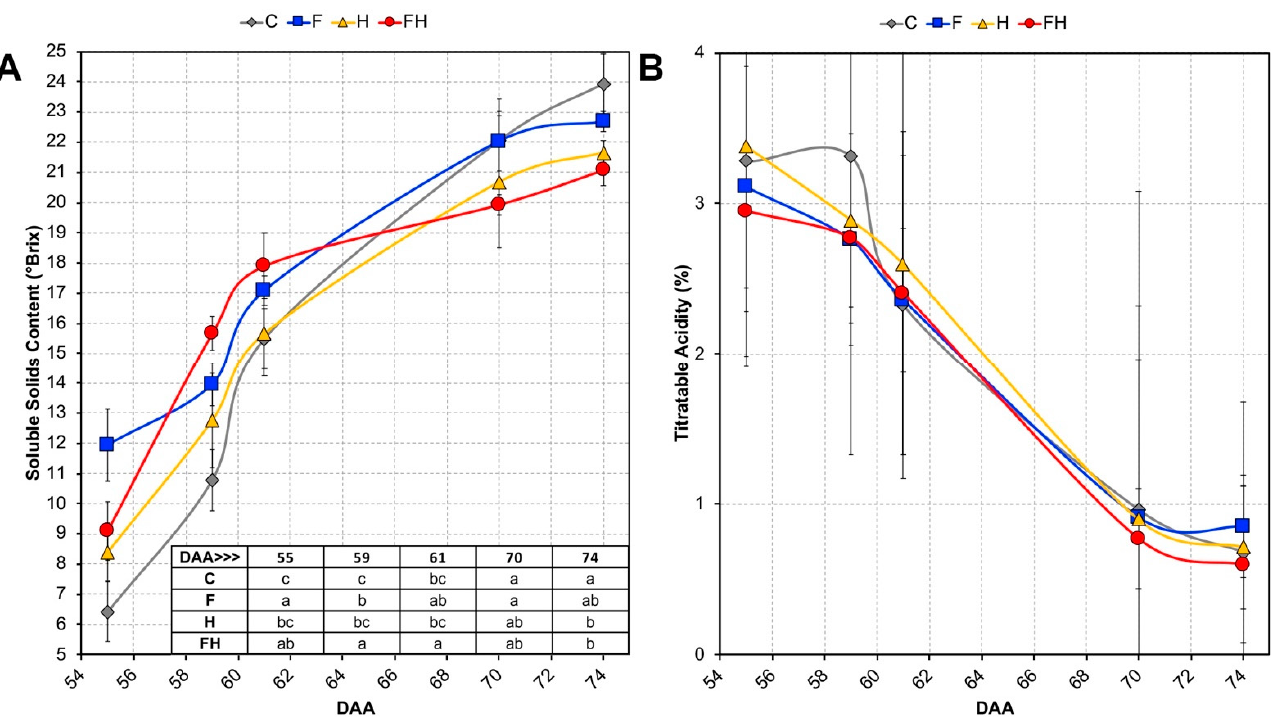
Figure 2. Soluble Solids Content (SSC; ( A ) and Titratable Acidity ( B ) were measured in 10 berries of each treatment, starting from the day when temperatures were increased (T1, 55 DAA) up to the end of the experiment, when berries were harvested (T5, 74 DAA). Bars represent standard error. Statistics were reported only for SSC with different letters marking statistically significant differences, while for titratable acidity, differences were all non-significant ( p ≤ 0.05). (C, control; F, flooded; H, heatwave; FH, flooded plus